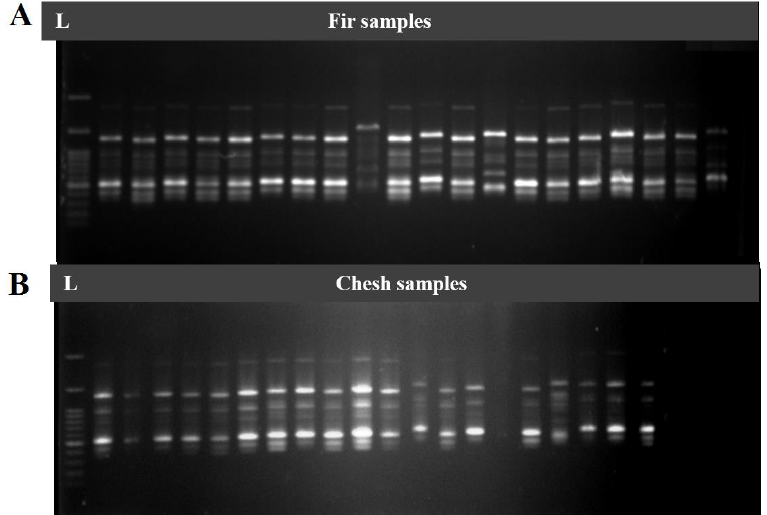
Fig. 5. A representative ISSR bands pattern of L. undulata populations obtained by primer ISSR-07: A) Firoozkooh populations; B) Cheshmeh Ali populations; L= DNA Ladder (100 bp to 3000 bp). Table 3. Genetic diversity estimates of L. undulata populations based on ISSR loci. Pop